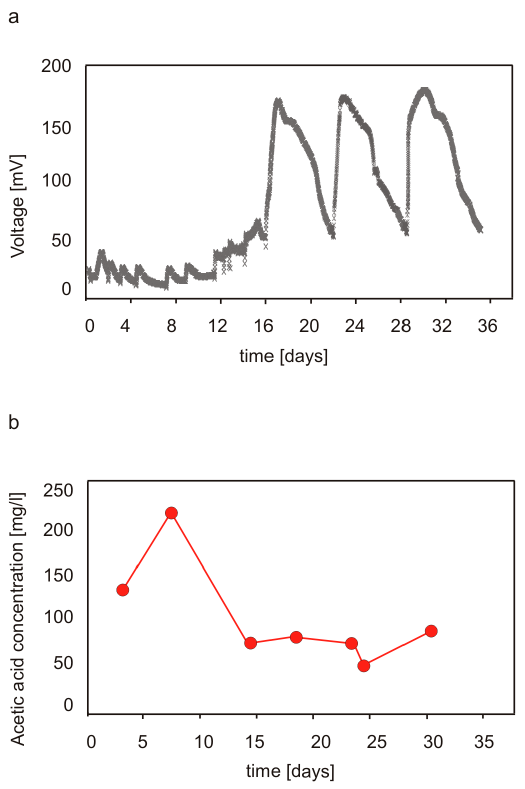
Figure 1. Voltage output ( a ) and acetate concentrations ( b ) over time in a cellulose-fed microbial fuel cell (MFC).